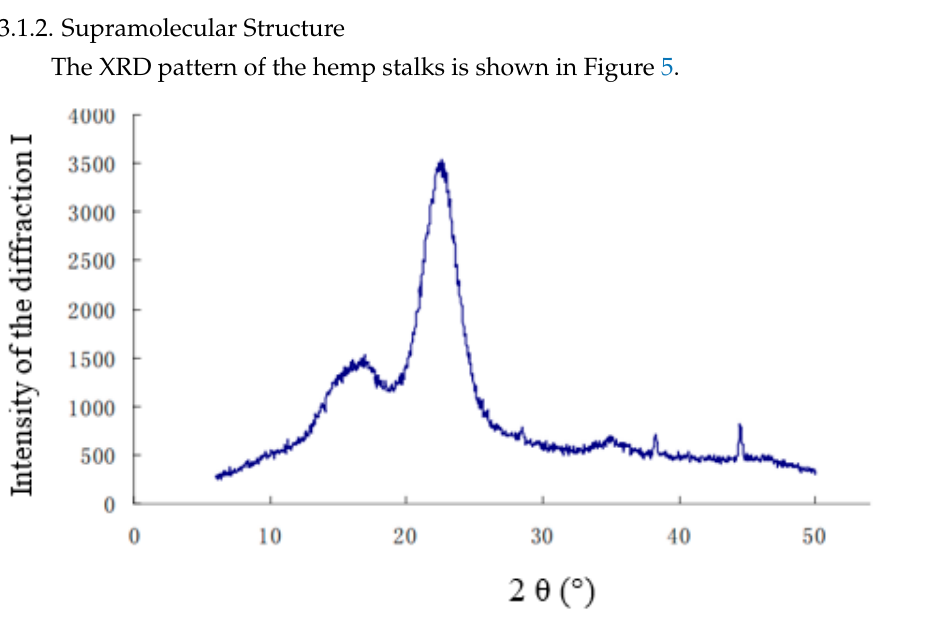
Figure 5. X-ray diffraction pattern of the hemp stalks.